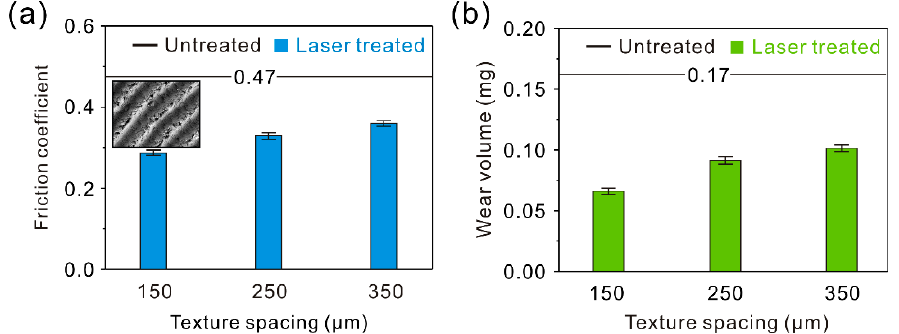
Figure 12. ( a ) Curve of the dynamic friction coefficient of the AGS with different texture spacings; ( b ) wear volume of the AGS with different texture spacings (load of 0.3 N, sliding speed of 100 mm/s, frictional pair of GCr15 bearing steel, friction time of 10 min).